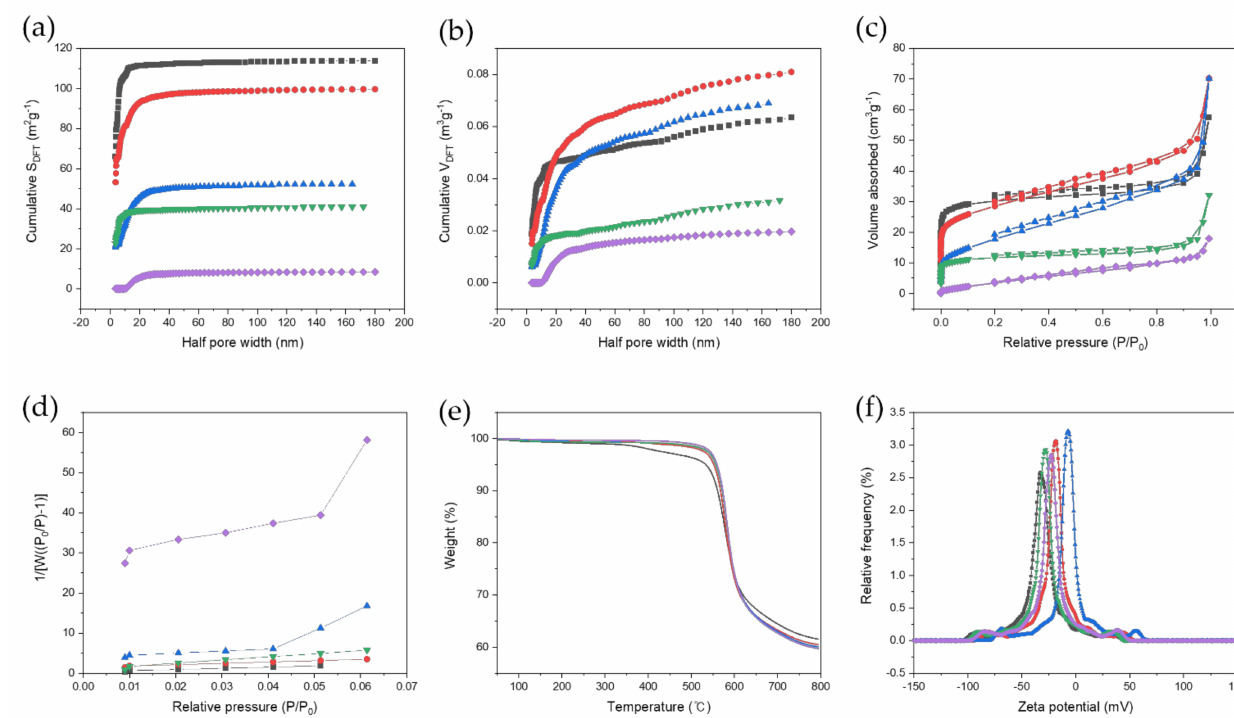
Figure 4. ( a ) Cumulative surface area and ( b ) cumulative pore volume derived from nitrogen physisorption data of the prepared LIG patterns fabricated according to laser scanning speed. ( c ) N2 adsorption–desorption isotherms of LIG patterns fabricated with different laser scanning speeds. ( d ) Plot of 1/[W((W(Po/P)-1)] and relative pressure for surface area calculation of LIG patterns, ( e ) TGA curves of LIG patterns, ( f ) zeta potential distribution curves for LIG patterns (violet: 100 mm/s, green: 80 mm/s, blue: 60 mm/s, red: 40 mm/s, black: 20